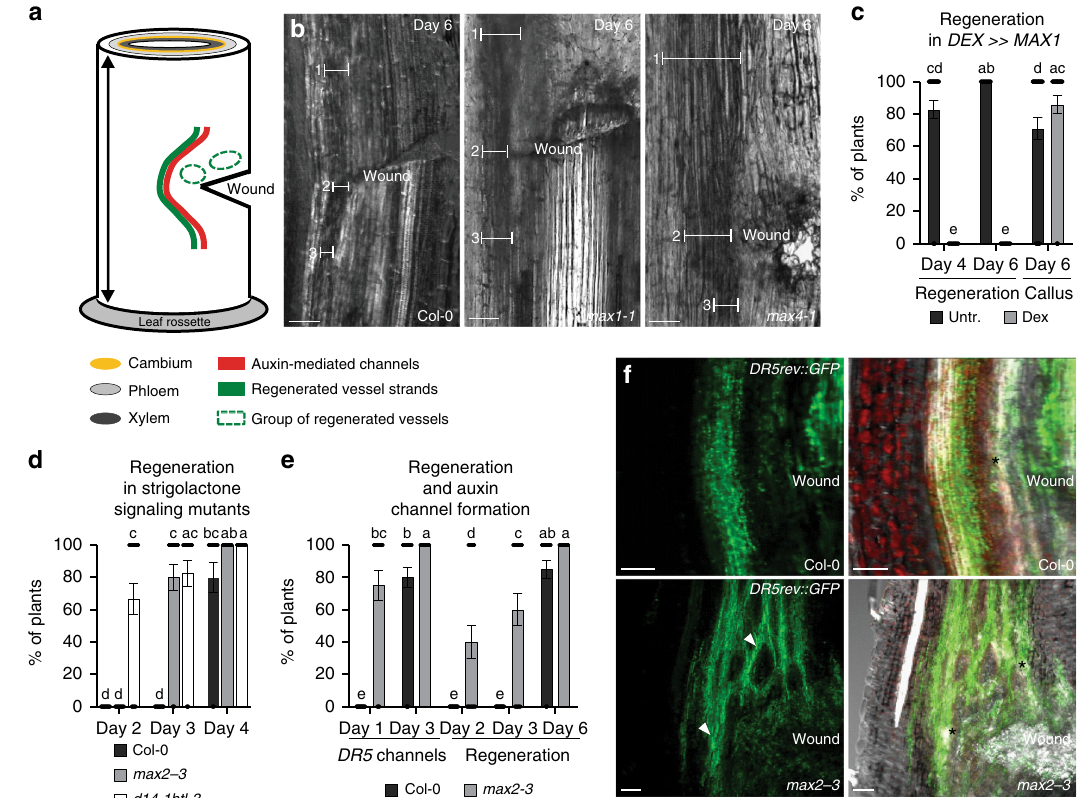
Fig. 2 SL regulation of vasculature regeneration after wounding in Arabidopsis stems. a Scheme representing spatial changes around a wound during vascular tissue regeneration in incised stems of Arabidopsis . Wounding is made in the basal part of in fl orescence stem just above the rosette leaves to disturb the longitudinal continuum of the vascular cambium. Green line represents development of regenerated vessel strands around a wound. Red line represents auxin-mediated channels formation. Green circles represent the groups of vessel-like cells developed from outer cortex or callus in the neighborhood of the wound. b Vascular tissue regeneration in SL biosynthesis defective mutants max1-1 and max4-1 . Line segments indicate the thickness of regenerated vasculature; above the wound (1), close to the wound (2), below the wound (3). Scale bars: 100 µ m. c Vascular tissue regeneration in wounded DEX ≫ MAX1 plants. Data are expressed as mean ± s.e.m. ( n ≥ 22 in fl orescence stems). Means with different letters are signi fi cantly different at